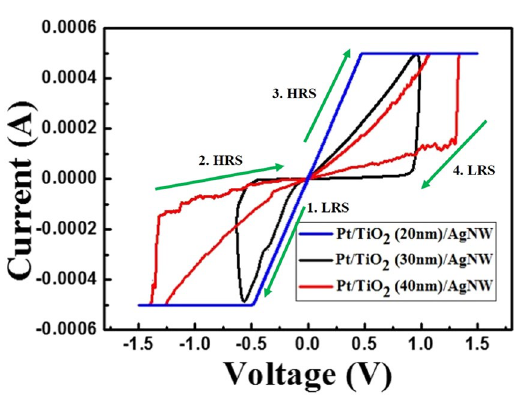
Figure 4. Typical bipolar I–V curve of the FT-RRAM device with different TiO 2 insulator